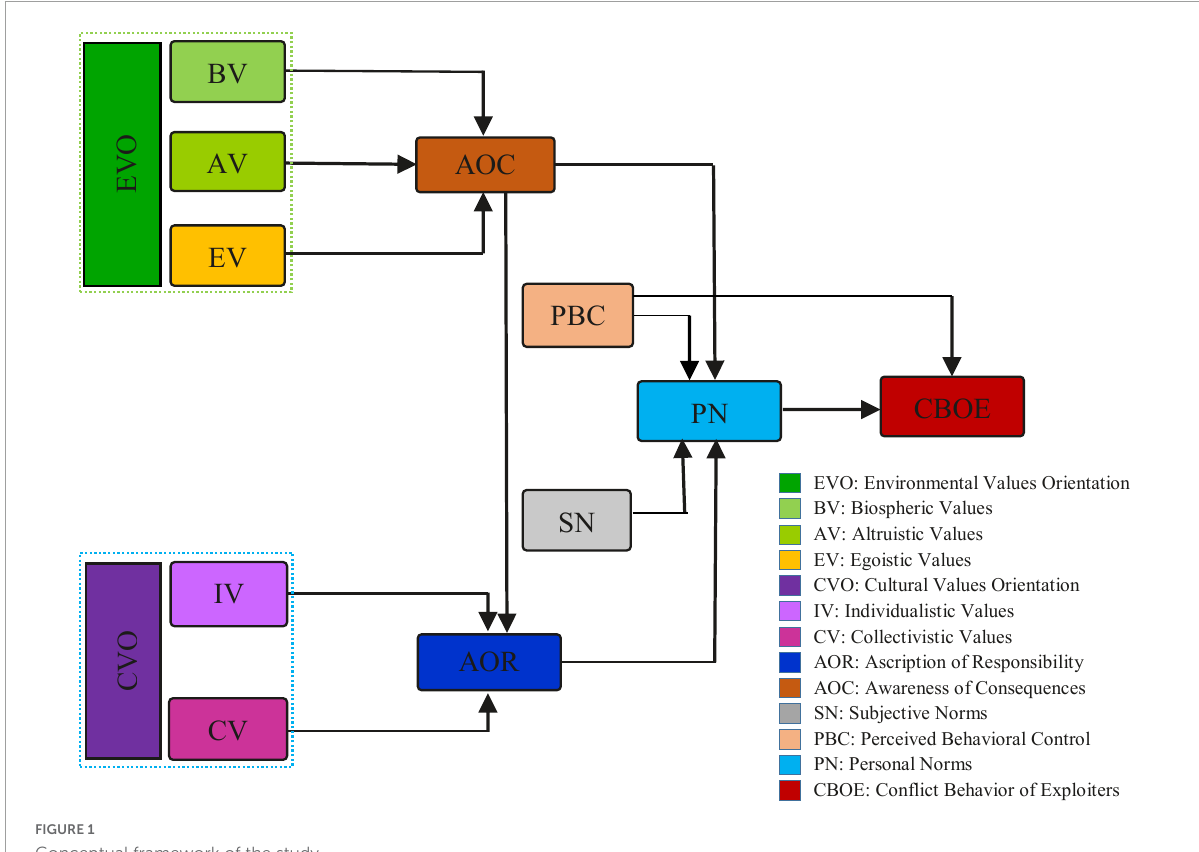
FIGURE1 Conceptual framework of the